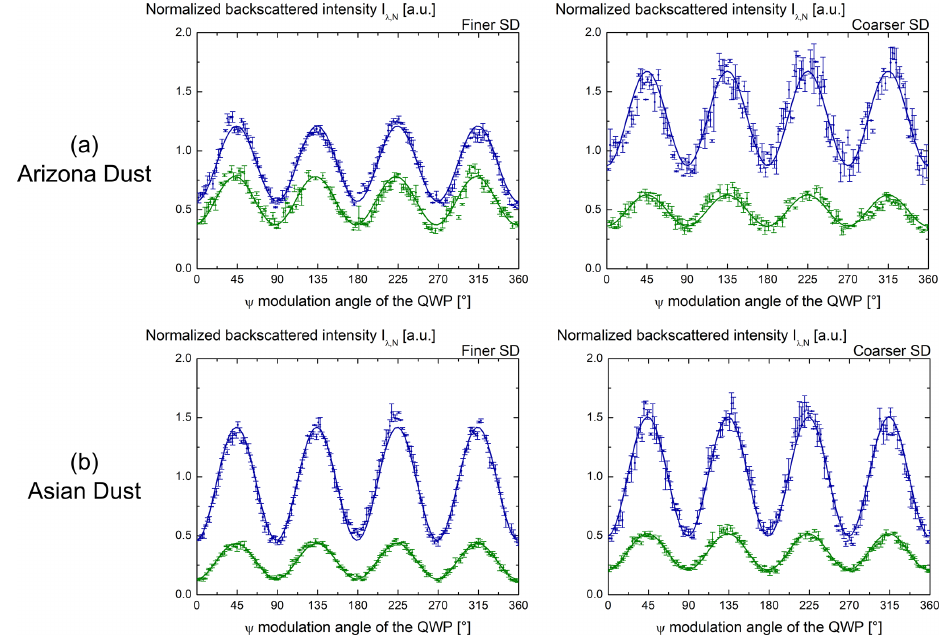
Figure 4. Normalized backscattered light intensity I λ, N = I λ (π)/I λ (θ 0 ) of Arizona (a) and Asian dust (b) for finer SD (left panels) and coarser SD (right panels), using the laboratory π -polarimeter at lidar exact backscattering angle ( θ = π ) at 355 (blue) and 532nm (green) wavelengths. The experimental data points are fitted with Eq. (6) to derive F 22 ,λ /F 11 ,λ , and then the dust lidar PDR is derived using Eq. (7). Care should be taken when comparing I λ, N for Arizona and Asian dust, since the applied voltage to the UV and VIS photodetectors was adjusted to increase the signal-to-noise ratio, as explained in Sect. 3.4. The Arizona dust lidar PDR, retrieved from I λ,m /(I λ,m + I λ,M ) , is higher than that of Asian dust. Table 1. Laboratory measurement of the PDR of Arizona and Asian dust at 355 and 532nm wavelengths, for the finer and coarser SD. The PDR is calculated with Eq. (7) after the derivation of F 22 ,λ /F 11 ,λ using the laboratory π -polarimeter presented in Sect. 3.2. The uncertainty on F 22 ,λ /F 11 ,λ is deduced from the evaluation of b λ /a λ , itself deduced from the least-square fit adjustment of I λ . The uncertainty on F 22 ,λ /F 11 ,λ is mostly dominated by statistical uncertainties, since our biases are minimized, as explained in Sect. 3.5. Bold values are used to emphasize the presented